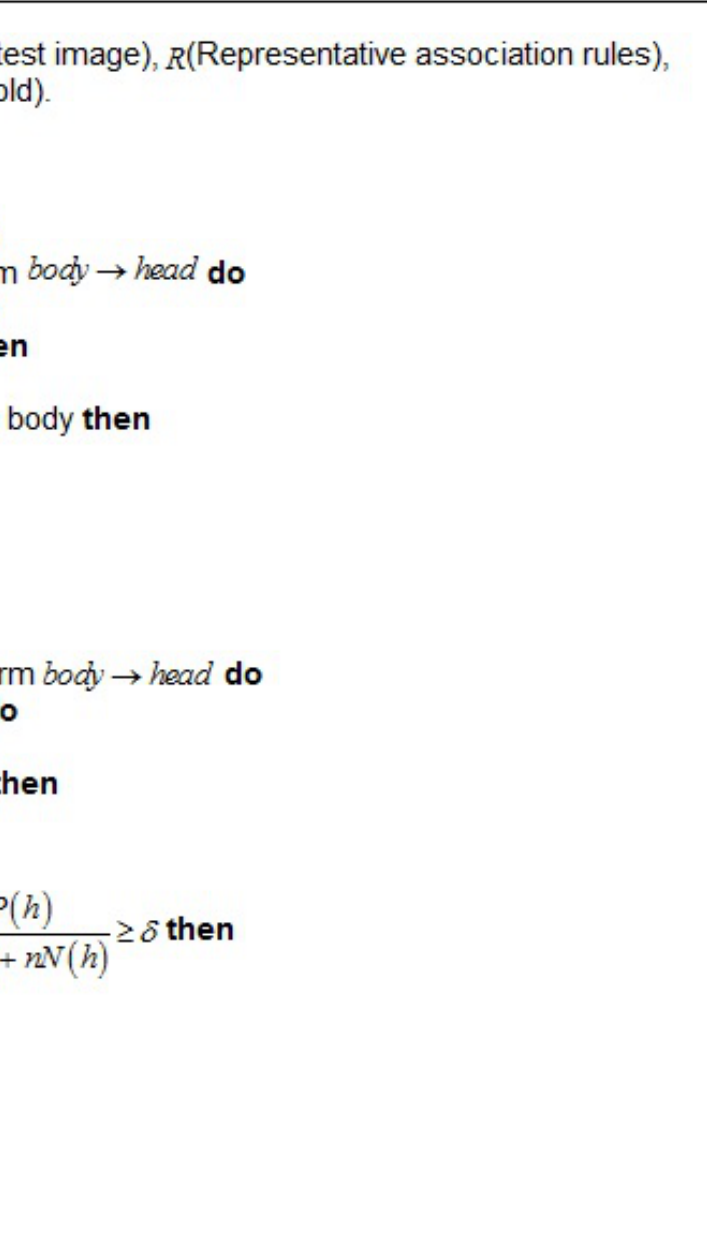
Figure 7. The AMIDE Algorithm.